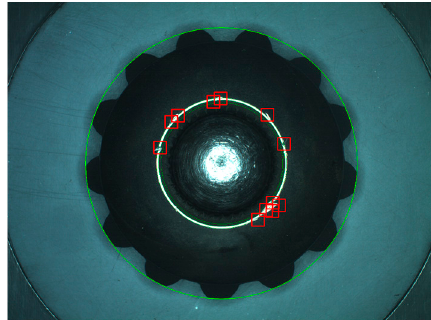
Figure 18. Inspection of bottom surface of gear A 4 , red boxes mark defects and green circle marks circumcircle.